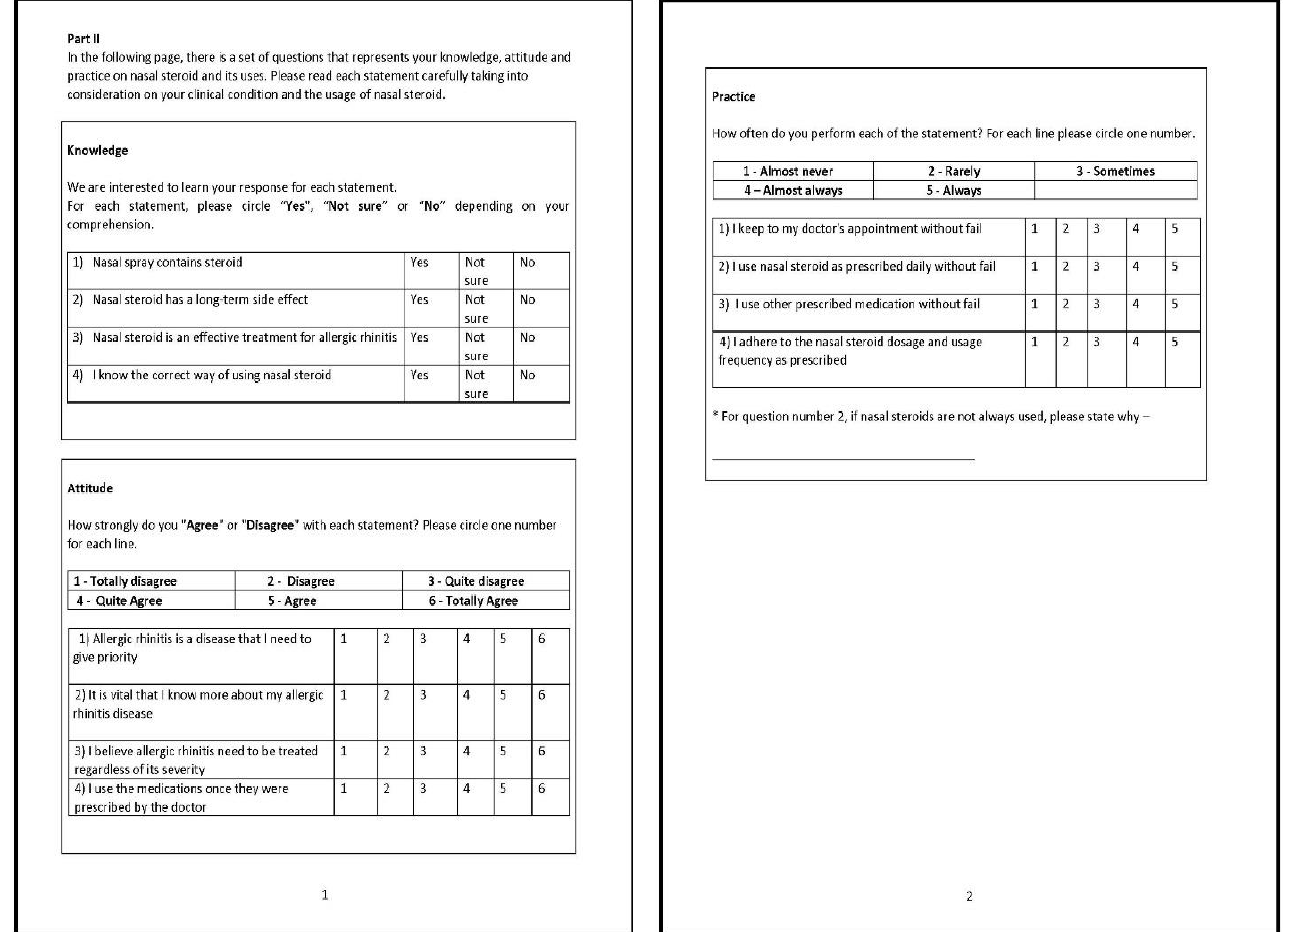
Figure 1. The final validated KAP-INCS questionnaire consists of 12 items (knowledge domain consists of four questions; attitude domain consists of four questions; and practice domain consists of four questions).